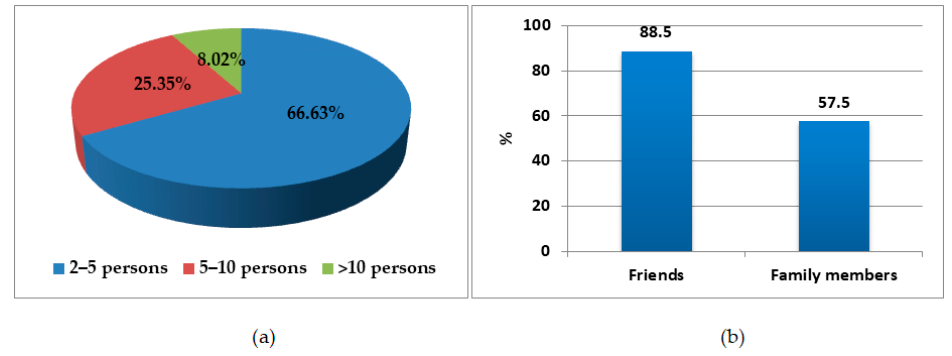
Figure 1. ( a ) Preferred tourist group size; and ( b ) percentage of friend and family tourist group